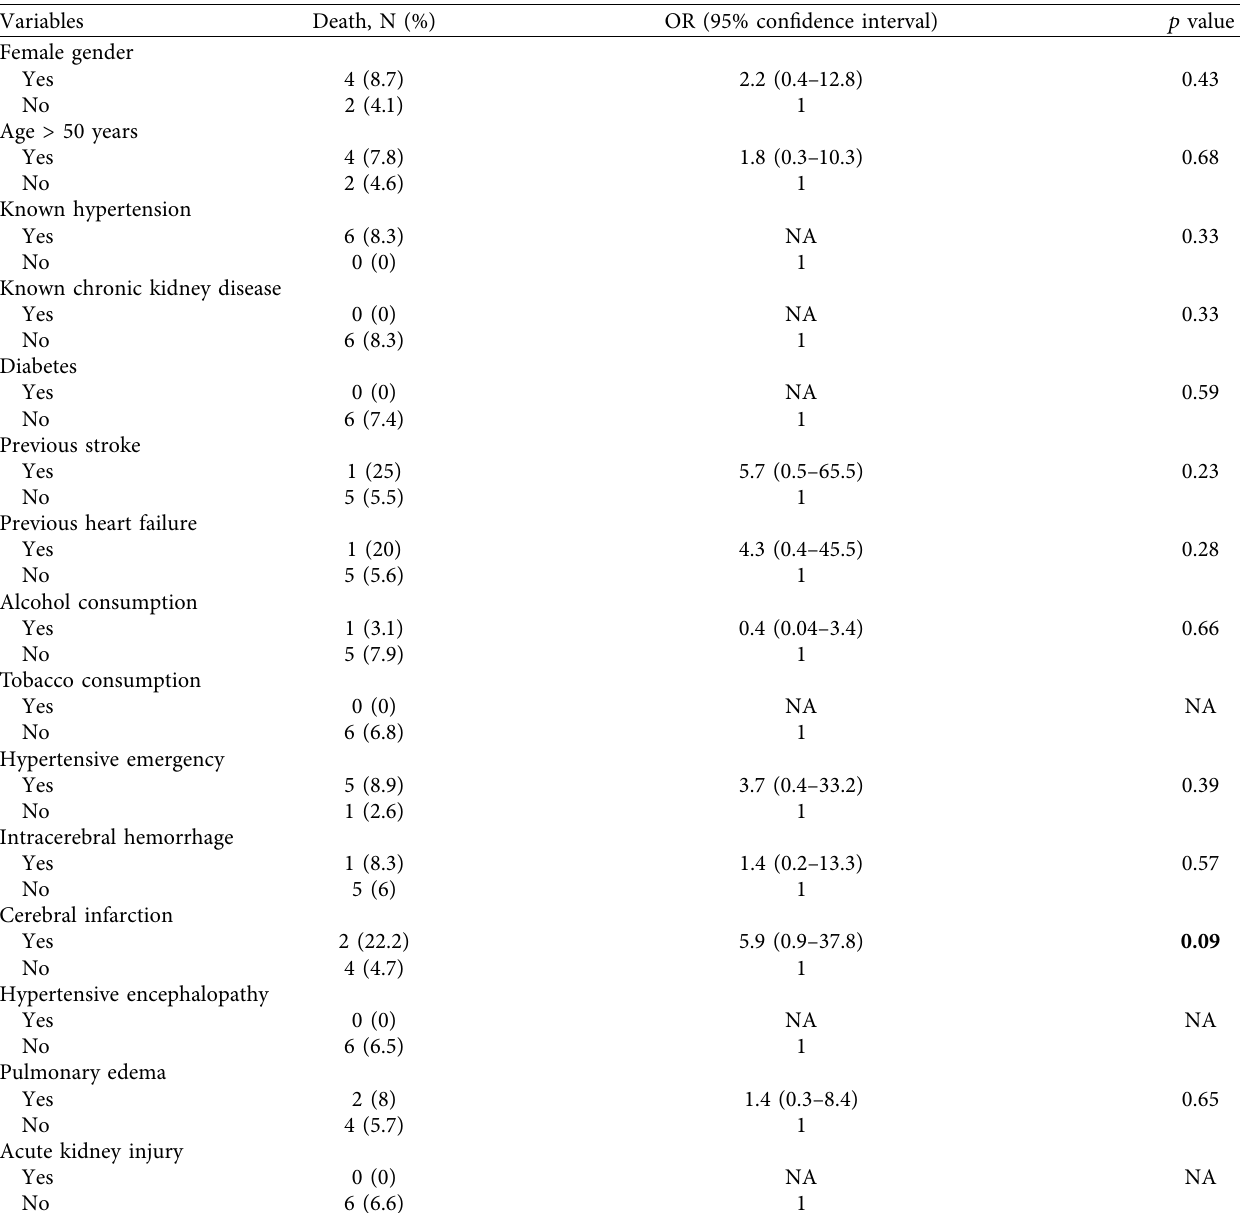
Table 4: Factors associated with death in the study population ( n � 95)